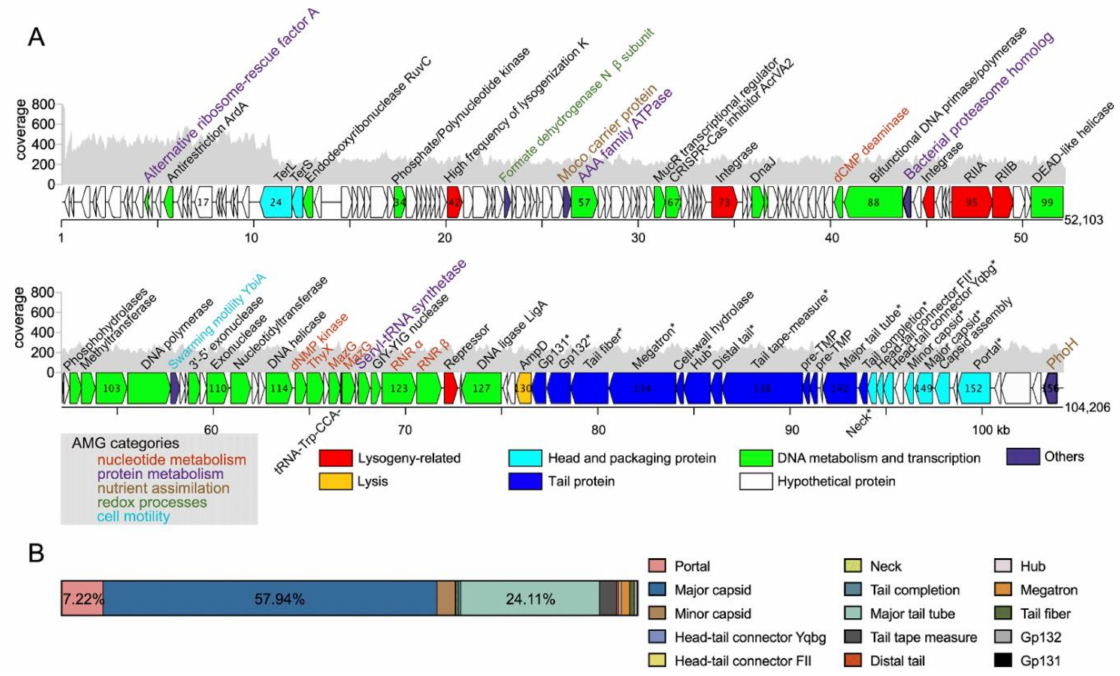
Figure 3. Genomic and proteomic features of phage RXM. ( A ) Full-genome map of RXM. Mean fold coverage at each position is shown using gray bars. The orientation of each predicted gene product corresponds to the direction of transcription. Genes within different functional categories are indicated by the colors noted below. Predicted phage AMGs are marked with different colors based on different functional categories displayed in the lower-left quadrant. Confirmed viral structural genes are marked with an asterisk (*). ( B ) Relative abundance of RXM structural proteins detected using